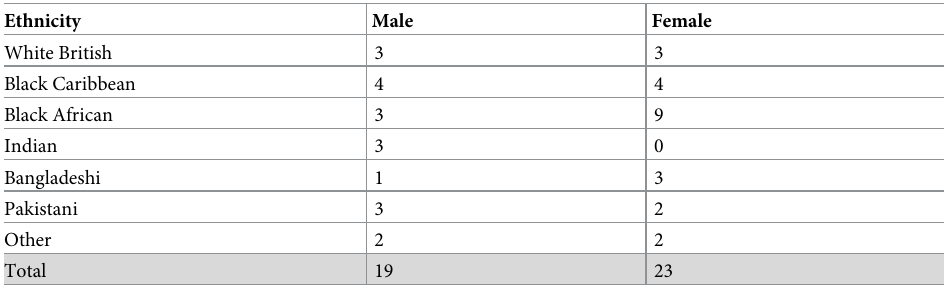
Table 1. Qualitative interview